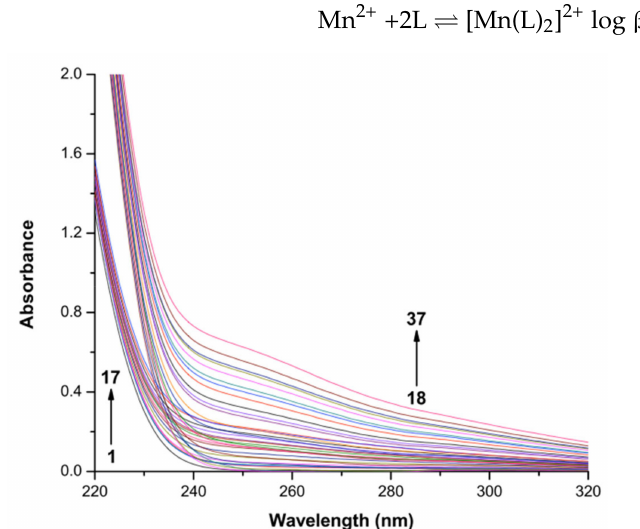
Figure 1. Absorption spectra of manganese(II)–ethylenediamine system in methanol solution. For spectra 1 to 17, [Mn(II)] = 0.16 mM and ethylenediamine concentration (mM): (1) 0.054; (2) 0.072; (3) 0.09; (4) 0.108; (5) 0.126; (6) 0.144; (7) 0.16; (8) 0.18; (9) 0.198; (10) 0.216; (11) 0.234; (12) 0.252; (13) 0.27; (14) 0.288; (15) 0.306; (16) 0.324; (17) 0.342. For spectra 18 to 37, [Mn(II)] = 0.3 mM and ethylenediamine concentration (mM): (18) 0.03; (19) 0.06; (20) 0.09; (21) 0.12; (22) 0.15; (23) 0.18; (24) 0.21; (25) 0.24; (26) 0.27; (27) 0.3; (28) 0.33; (29) 0.36; (30) 0.39; (31) 0.42; (32) 0.45; (33) 0.48; (34) 0.51; (35) 0.54; (36) 0.57; (37)